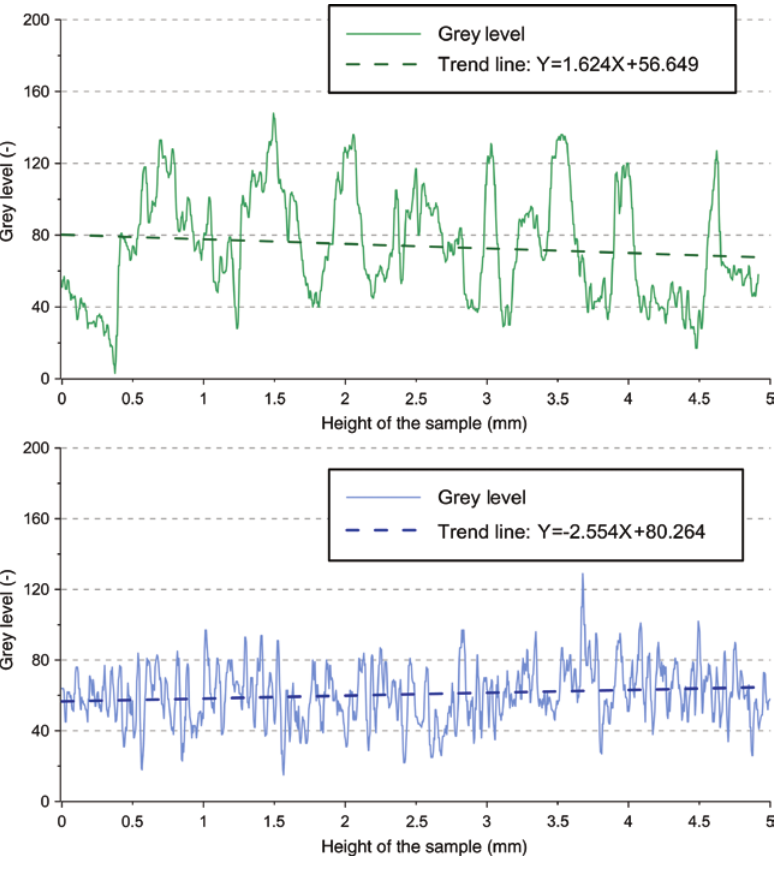
Figure 7: Attenuation profiles for the mortar (top) and gypsum (bottom) specimens.